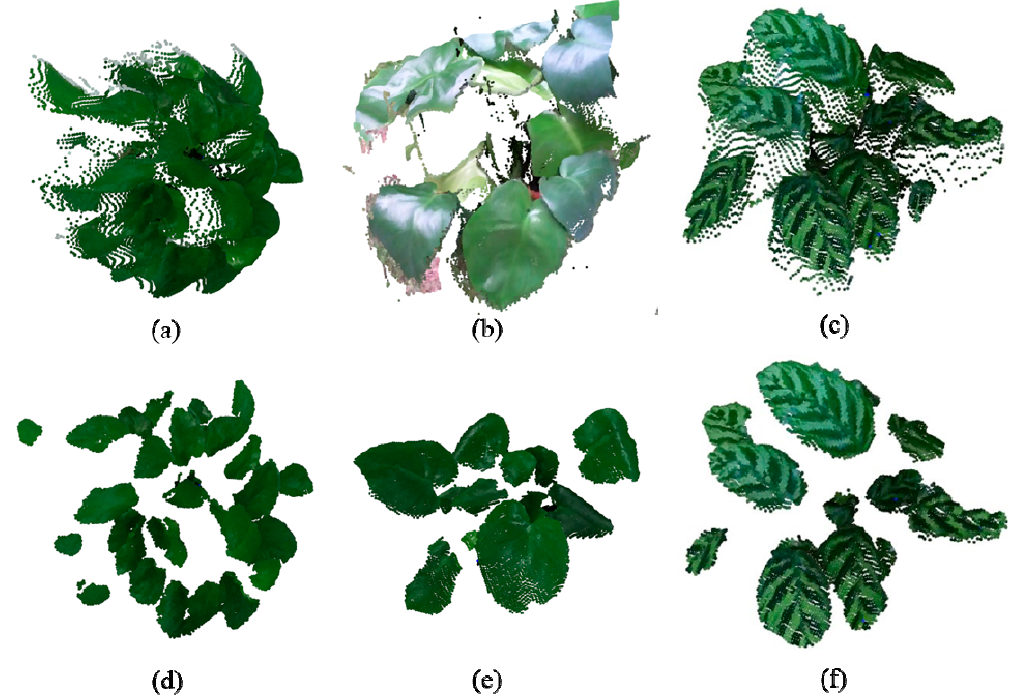
Figure 4. The original and pre-processed point clouds of the three greenhouse sample plants: ( a ) the original point cloud of Epipremnum aureum ; ( b ) the original point cloud of Monstera deliciosa ; ( c ) the original point cloud of Calathea makoyana ; ( d ) the pre-processed result on Epipremnum aureum ; ( e ) the pre-processed point cloud on ( b ); and, ( f ) the preprocessed result on ( c ).